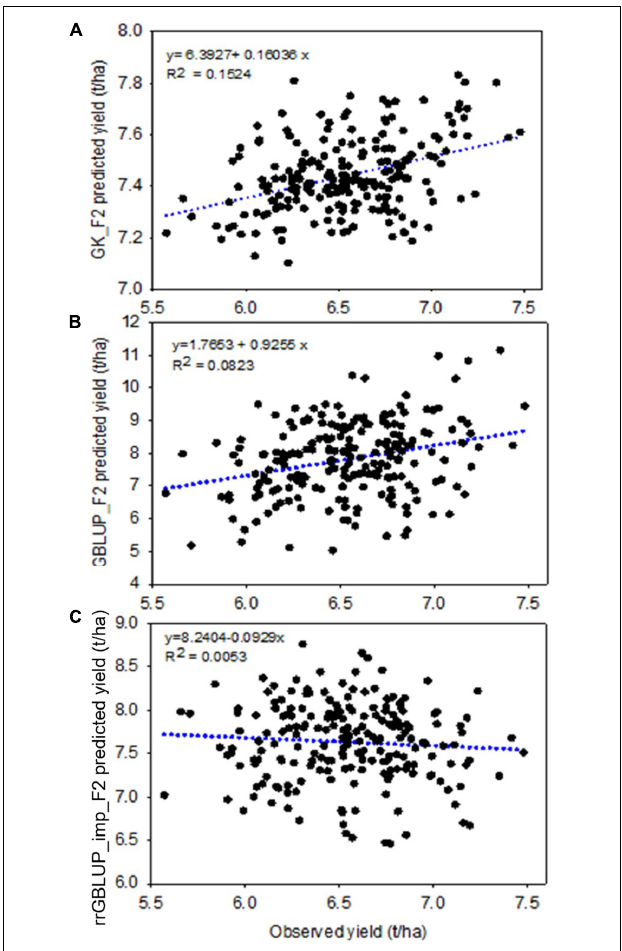
FIGURE 5 | Experiment 2: Scatter plot showing the correlation between F2 predicted yield, estimated with different prediction models GK (top, A ), GBLUP (middle, B ), and rrGBLUP_imp (low, C ), with an observed yield of 213 derived F2:4 lines. GBLUP, genomic best linear unbiased prediction; rrGBLUP, Ridge Regression BLUP; GK, Gaussian